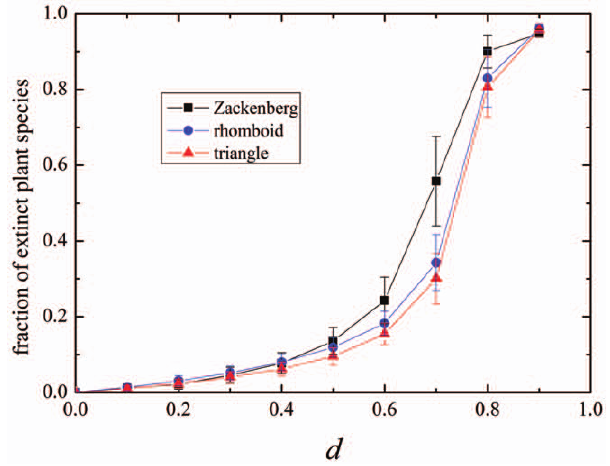
Figure 4. Fraction of extinct plants as a function of the destruction parameter, in two network models and a natural network. Links density is r ~ 0 : 18 , average of 1000 realizations.